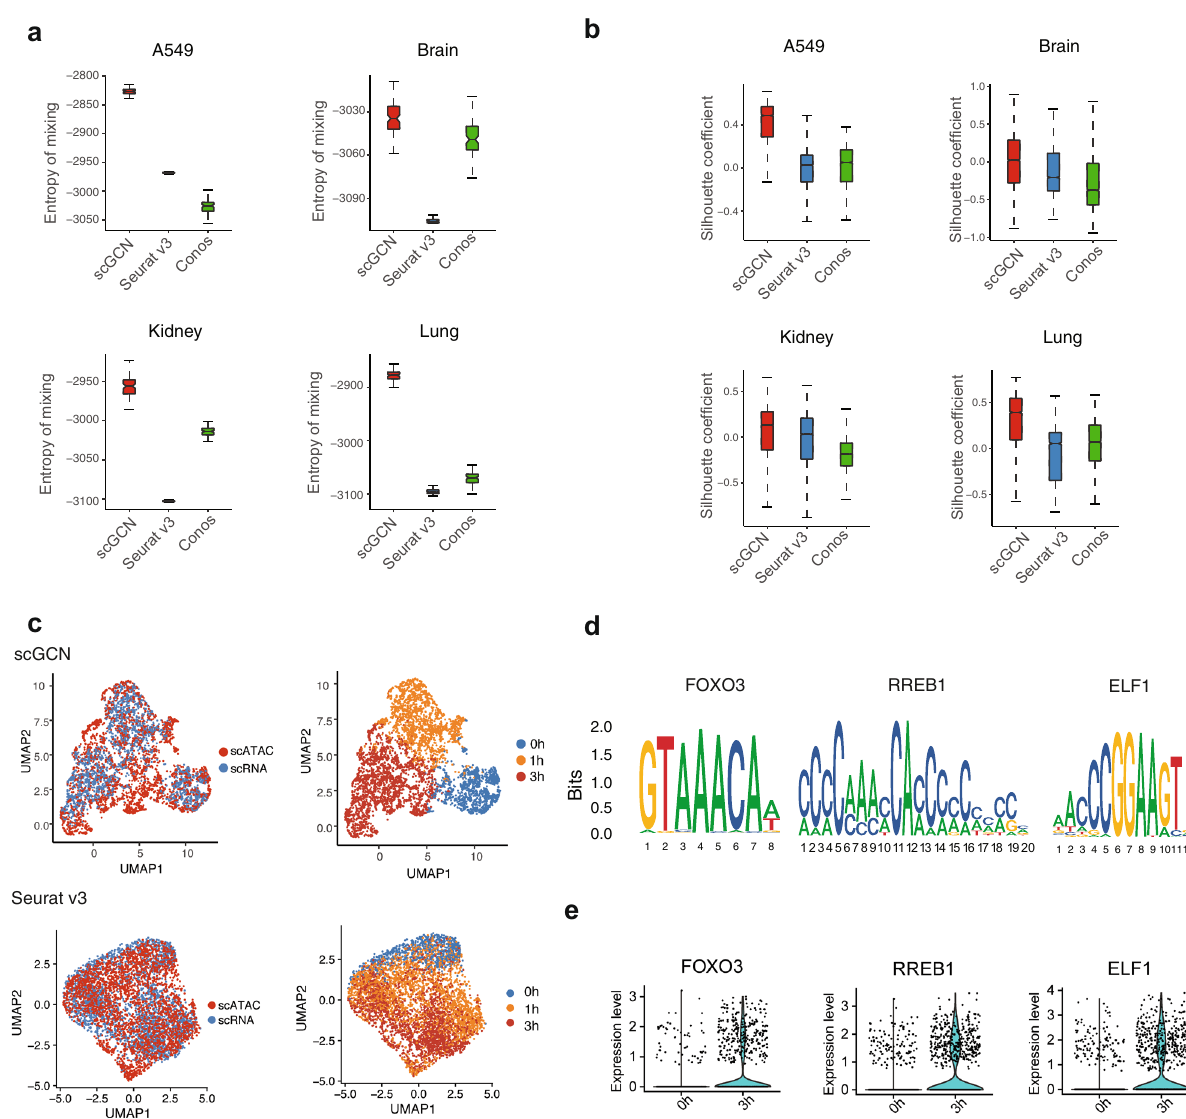
Fig. 5 Performance of scGCN and its comparison with other methods using four paired cross-omics datasets. a , b For each method, performance metrics including two indexes, i.e., batch effects entropy (A549 n = 100; Brain n = 100; Kidney n = 100; Lung n = 100) and silhouette index (A549 n = 5282; Brain n = 6737; Kidney n = 17,674; Lung n = 4994), are used to evaluate the level of cell mixing across datasets and the preservation of local structure within dataset. Data are represented as boxplots where the middle line is the median, the lower and upper hinges correspond to the fi rst and third quartiles, the upper whisker extends from the hinge to the largest value no further than 1.5× the inter-quartile range (IQR) from the hinge, and the lower whisker extends from the hinge to the smallest value at most 1.5× IQR of the hinge. c UMAP plots of A549 cells colored by dataset (scRNAseq, scATAC- seq) and by cell states (0, 1, and 3 h), after integration by scGCN and Seurat v3. d Overrepresented DNA motifs are identi fi ed in 3 h-speci fi c accessibility peaks, with FOXO3, RREB1, and ELF1 motifs as the most highly enriched motifs. e These motifs also exhibit upregulated expression in scRNA-seq cells at 3 h. Source data are provided as a Source Data fi